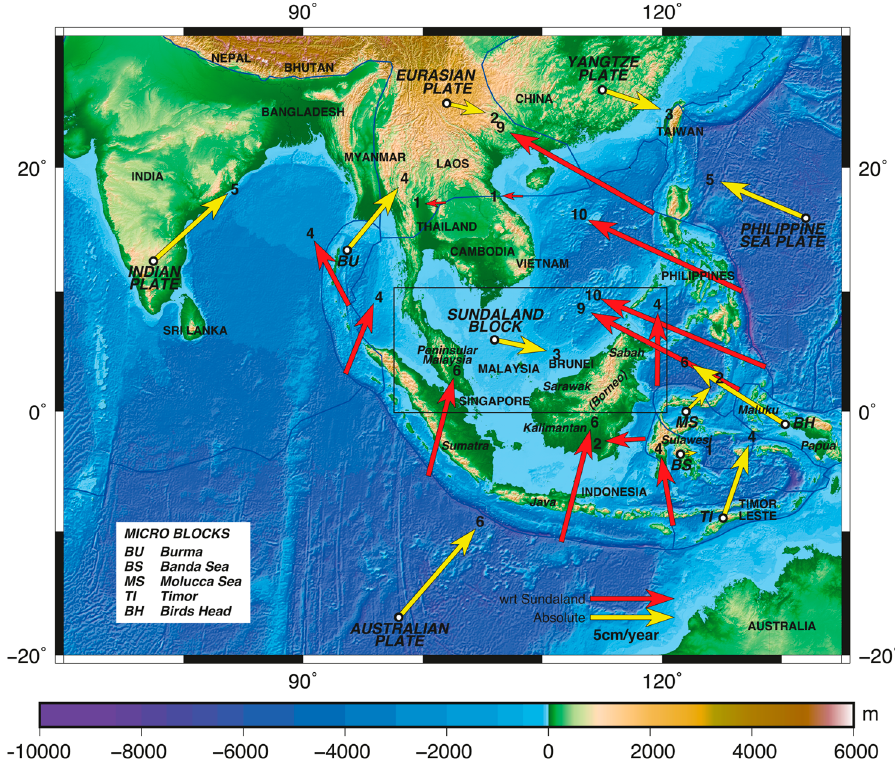
Figure 1. Tectonic setting of Southeast Asia with Peninsular Malaysia and East Malaysia (Sarawak and Sabah) being part of the Sundaland block along with the estimated relative and absolute horizontal velocities of plates and main/micro blocks that surround Sundaland (velocity magnitude in cm/year plotted near the head of the vectors). Approximate boundaries of plates (blue lines) are based on Bird [22]. Relative velocities on selected boundaries are with respect to Sundaland and calculated from Morvel56-NNR [23]. Absolute velocities are in IGS08 (ITRF2008) based on Sundaland motion from Mustafar et al. [24] and Morvel56-NNR plate vectors relative to Sundaland. The study of the (vertical) tectonic motions of Phuket Island in South Thailand (north of Peninsular Malaysia) by Simons et al. [5] shows significant changes in (inter-, co-, and post-seismic) land deformation in the past 25 years. The region is located (similar to the northwest of Peninsular Malaysia) at the edge of the Australian/Indian–Sundaland plate boundary deformation zone and has displayed significant deformations prior to, during, and after the 2004 megathrust earthquake. Although no vertical co-seismic position